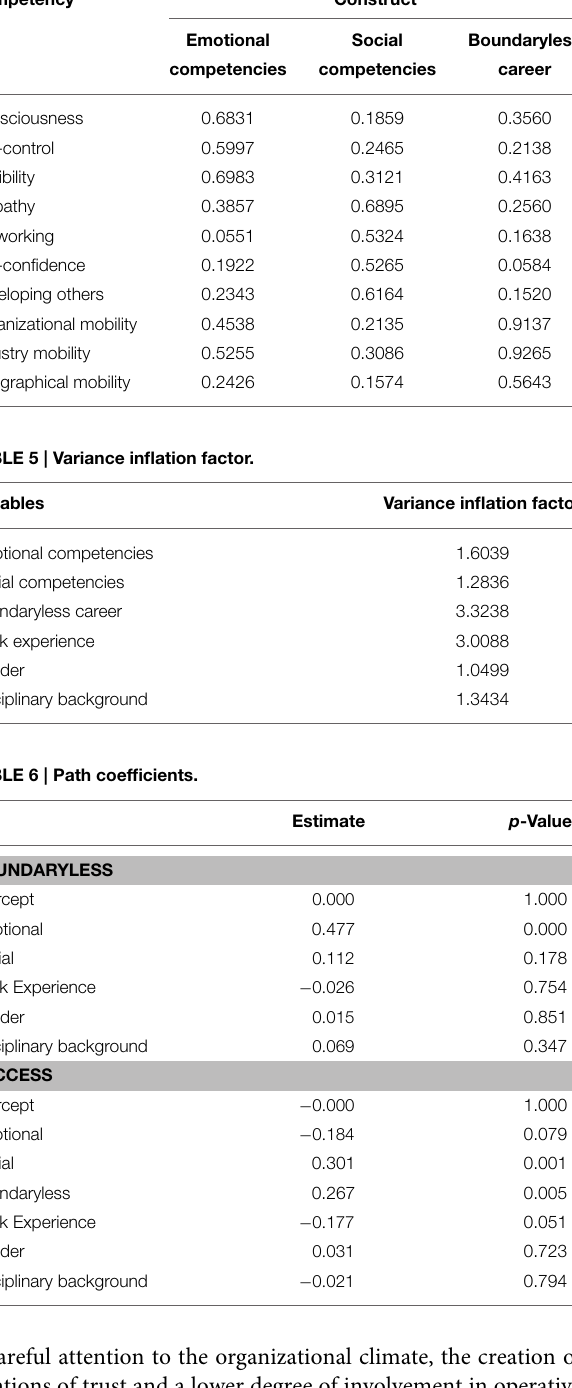
TABLE 3 | Loadings for the complete and reduced model yielded by PLS-PM model.